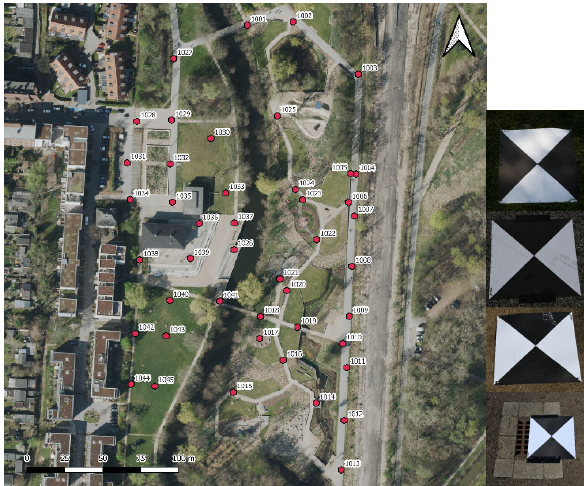
Figure 1: Ground control point distribution in the UAV test field Inselpark Hamburg-Wilhelmsburg (left) and targets on different surfaces (right) - grass, asphalt, sand and stone.